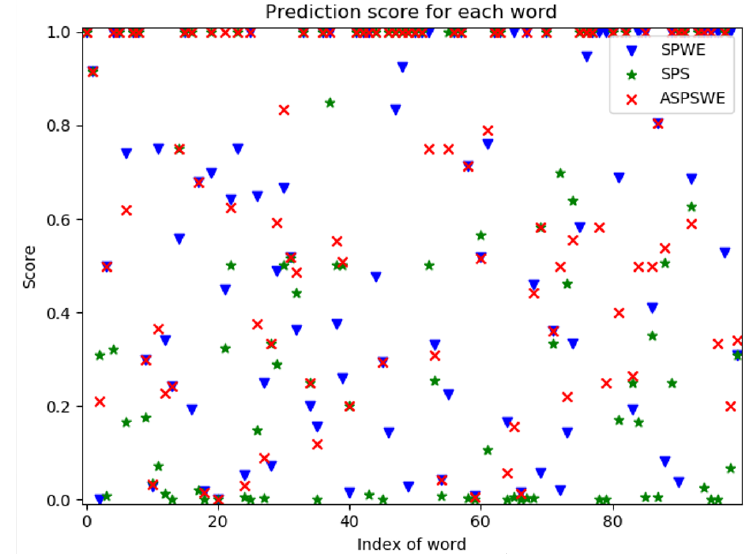
Figure 3. Randomly select 100 words and test their sememes prediction score (MAP value) of the SPWE, SPS, and ASPSW models.